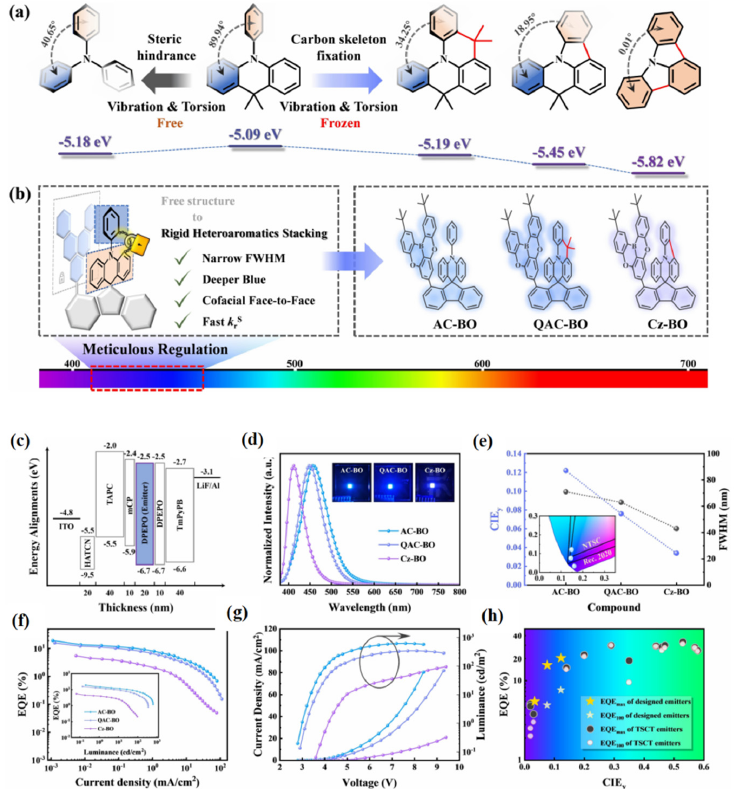
Figure 7. ( a ) The relationship between structures and HOMO levels of phenyl acridine and its skeleton-modified derivatives based on the DFT simulations. ( b ) Design strategy for controlling intramolecular stacking of rigid heteroaromatic compounds and the chemical structures of the designed compounds. ( c ) Device configuration and the related energy levels. ( d ) EL spectra with the photographs of devices (inset). ( e ) CIE y and FWHM of the EL spectra with CIE plot of EL spectra (inset). ( f ) EQE–current density curves with EQE–luminance curves (inset). ( g ) Current density–voltage–luminance curves. ( h ) EQE max s and EQEs at 100 cd m − 2 (EQE 100 ) of this work and the reported TSCT emitters. Reproduced with permission from Zhennan Zhao, Cheng Zeng, Xiaomei Peng et al., “Tuning Intramolecular Stacking of Rigid Heteroaromatic Compounds for High-Efficiency Deep-Blue Through-Space Charge-Transfer Emission”; published by John Wiley and Sons , 2022